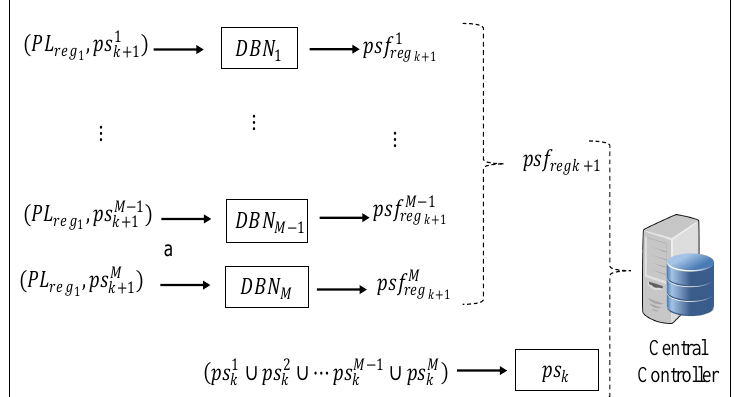
Figure 5. Training phase in the decentralized